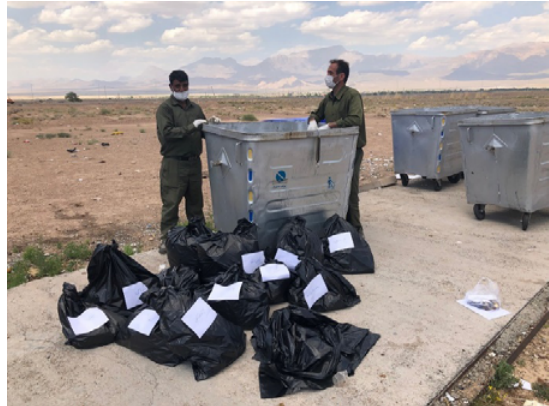
Figure 2. Average waste separated for physical analysis